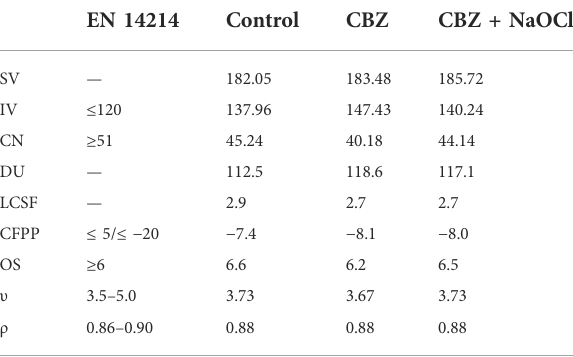
TABLE 5 Biodiesel properties of microalgal biomass calculated by fatty acid methyl ester composition. EN